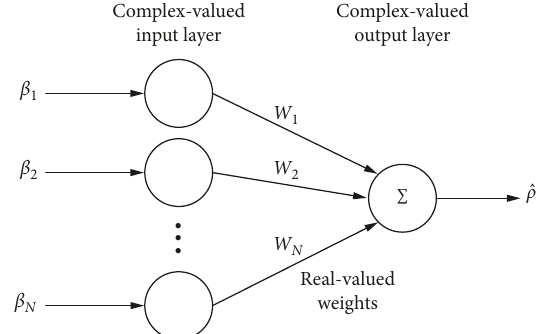
Figure 1: Proposed NN model for probe selection and power